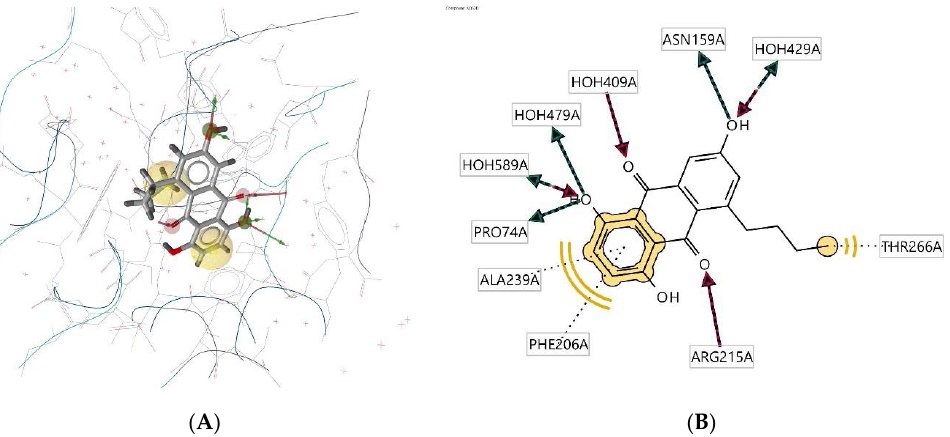
Figure 8. Ligand 52D interacts with the macromolecule. ( A ) 3D view of pharmacophore at the macromolecule binding site. ( B ) 2D view of pharmacophore. Pharmacophore features: hydrophobic interactions (H), yellow; hydrogen bond acceptor (HBA), red; hydrogen bond donor (HBD),